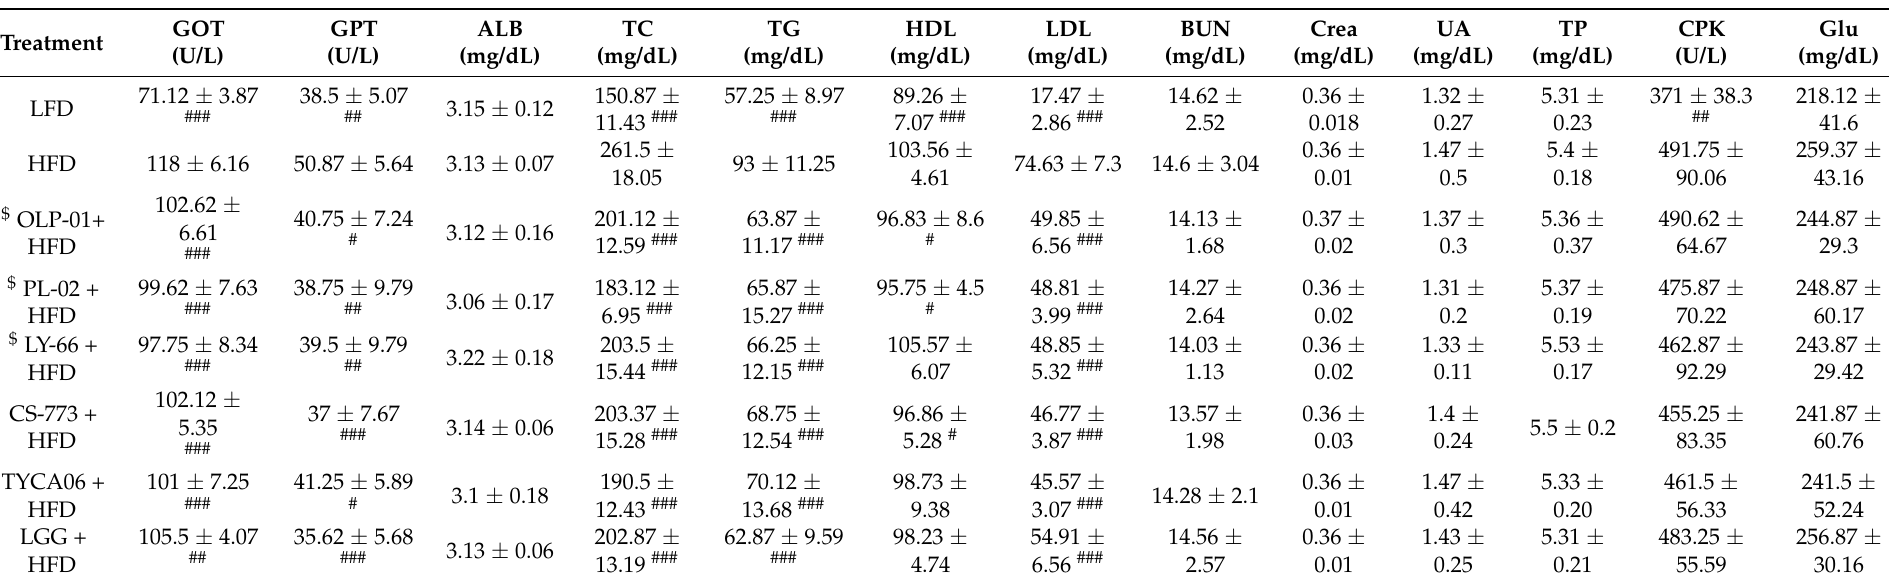
Table 3. Biochemical